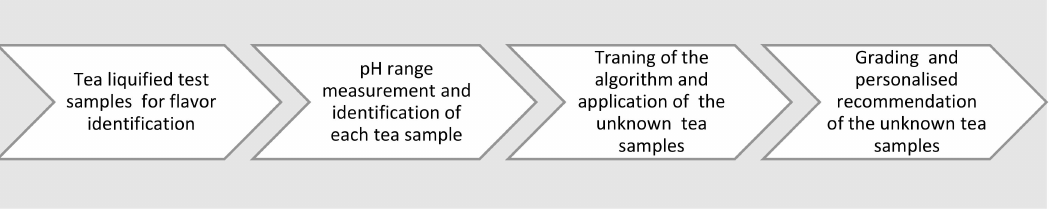
Figure 1. Tea flavor grading based on its pH